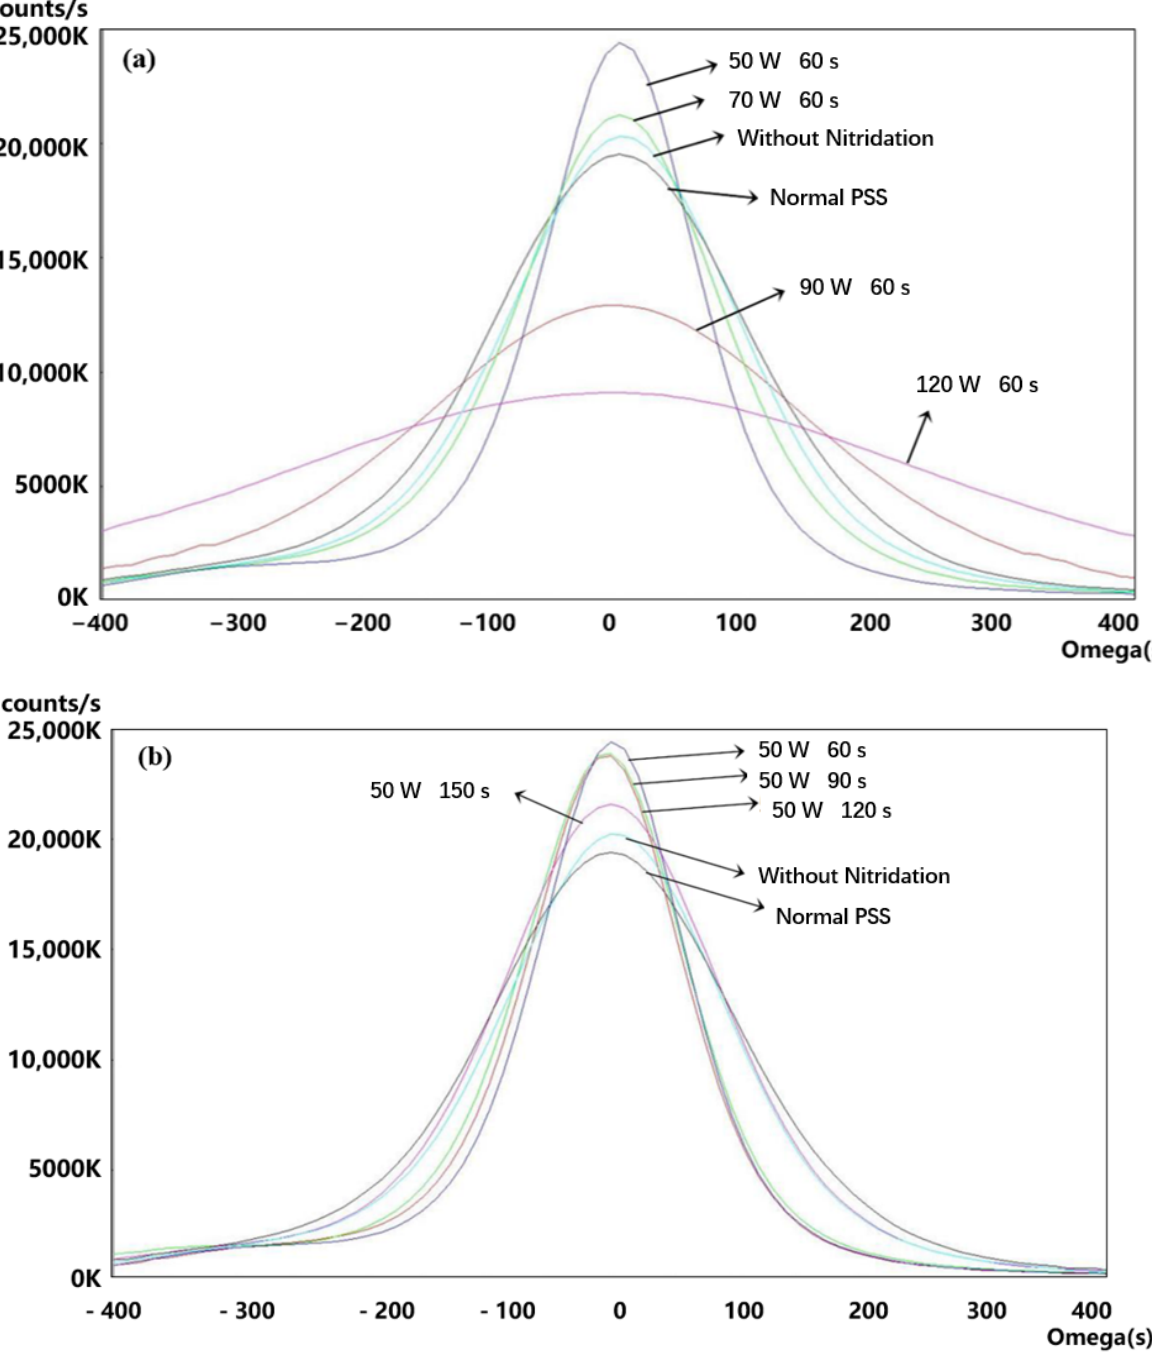
Figure 5. The ω mode scanning of (0002) planes on the samples of the complete LED epitaxial structure. The data were smoothed with the same order. ( a ) Results classified by the AC powers and ( b ) results classified by the nitridation times.